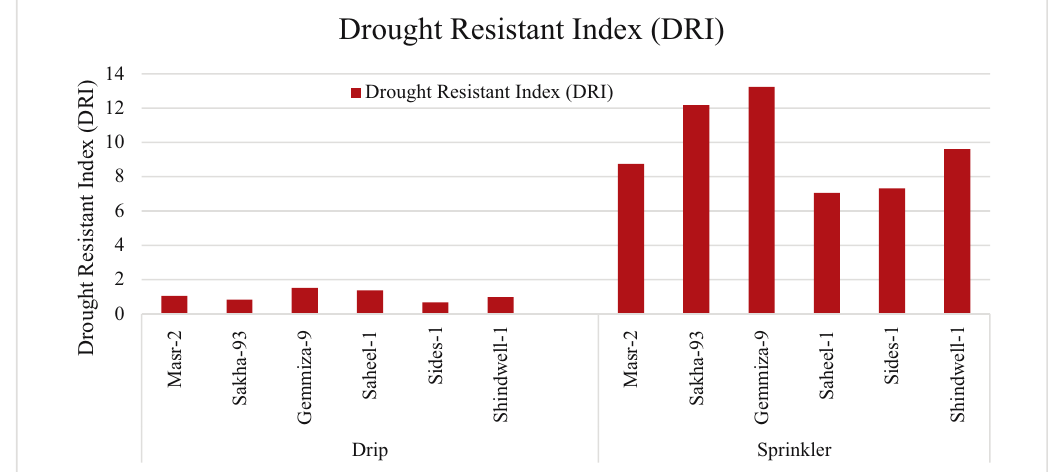
Figure 6: The e ff ect of wheat varieties and irrigation systems on the drought - resistant